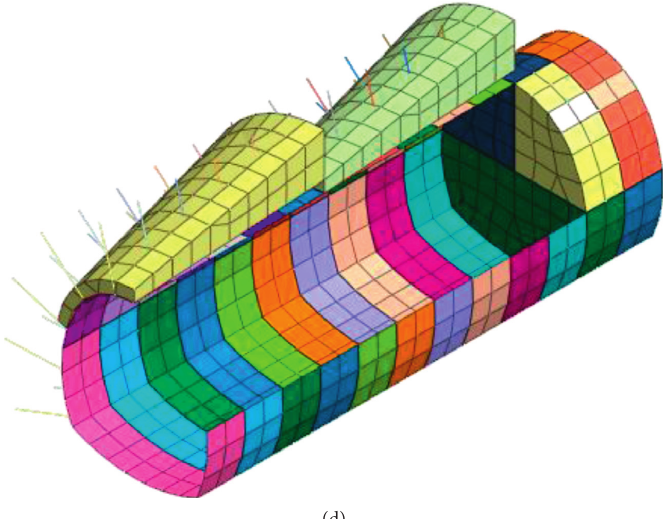
Figure 22: Simulation of underground tunnelling construction: (a) pre-grouting, (b) excavating the upper soil, (c) supporting the upper part, and (d) excavating and supporting the lower part.